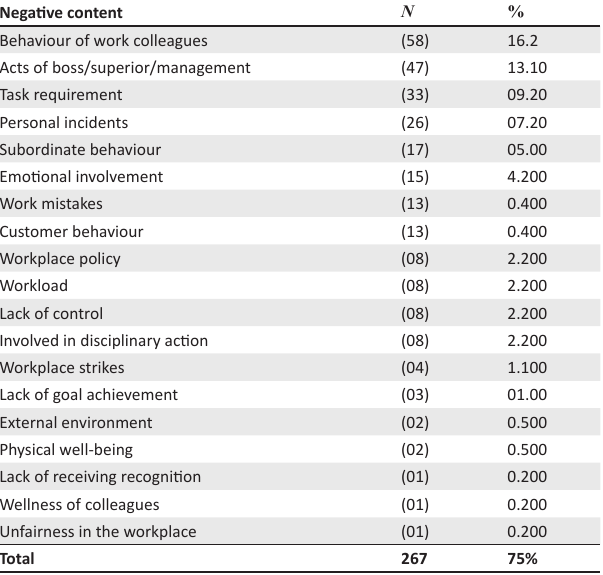
TABLE 1b: Categories of emotion episodes experienced with a negative content ( N =